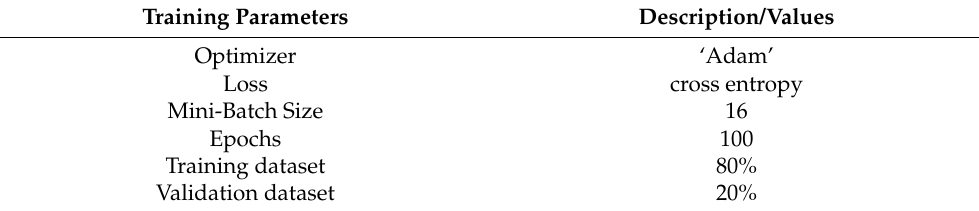
Table 2. CNN training